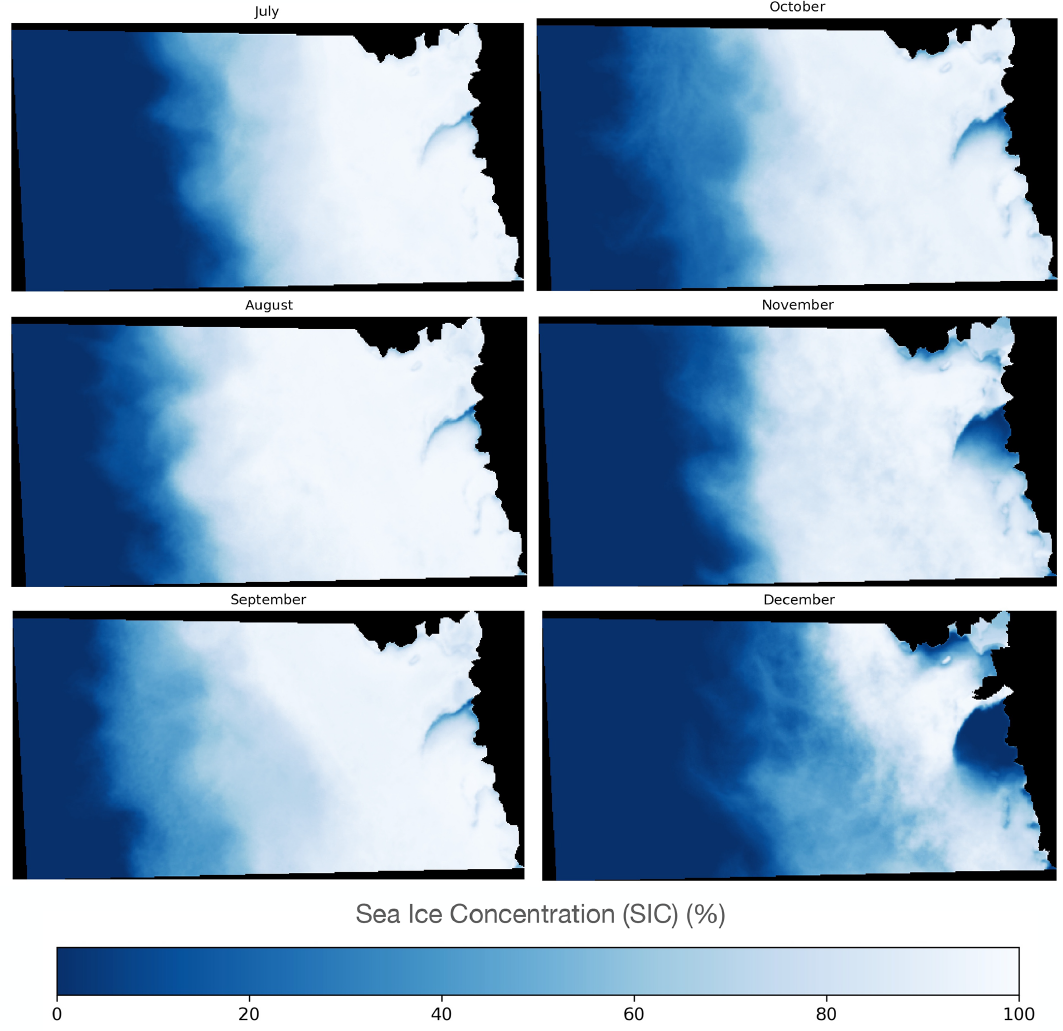
Figure 10. Mean monthly SIC for the broader ASP region for the period November 2016 to March 2021. The area corresponds to that shown by the red box in Fig. 1a. Daily data are shown in Video